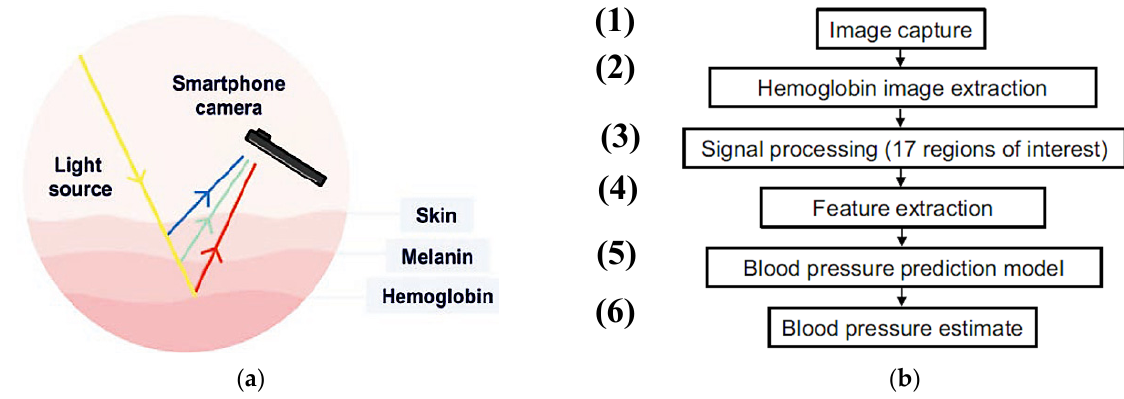
Figure 1. Graphical representation of TOI operation; ( a ) the light is re-emitted before being captured by the camera and moves beneath the skin surface. TOI technology, through the difference in re-emitted light between hemoglobin and melanin chromophores, uses the subtle changes in skin color to detect blood flow pulsation in the cardiovascular system; ( b ) operation sequence of TOI technique (1) image capture using a camera, (2) hemoglobin spatiotemporal images extraction, (3) hemoglobin signal processing, (4) feature extraction, (5) blood-pressure prediction trough model with advanced ML algorithms, and (6) blood pressure estimate [29].